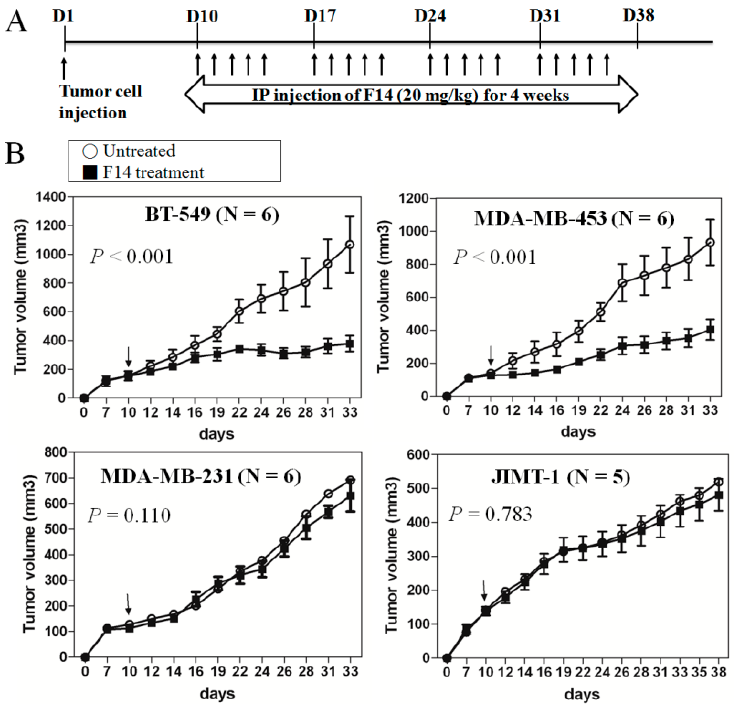
Figure 5. E ff ect of F14 in FAK-copy-gain breast cancer cells in a mouse xenograft model. ( A ) Scheme of experimental method. Once tumors were well-established after subcutaneous cancer cell injection (Day 10), F14 (20 mg / kg) was injected 5 days per week for 4 weeks. ( B ) Specific inhibition of tumor growth in FAK-copy-gain cells by F14 treatment in a mouse xenograft model ( p < 0.001 for both